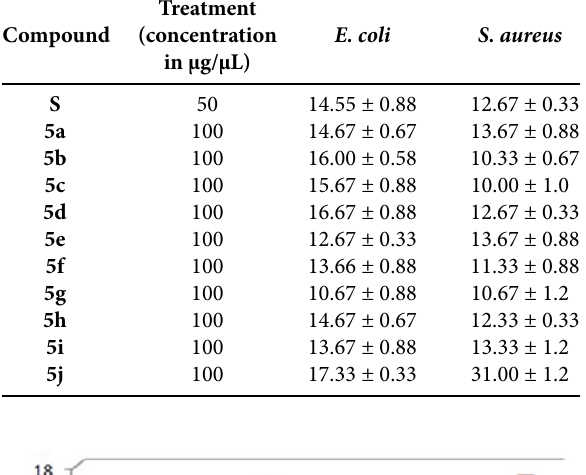
Table 2. Antibacterial activity of acyl thioureas 5a – j against E. coli and S. aureus Treatment